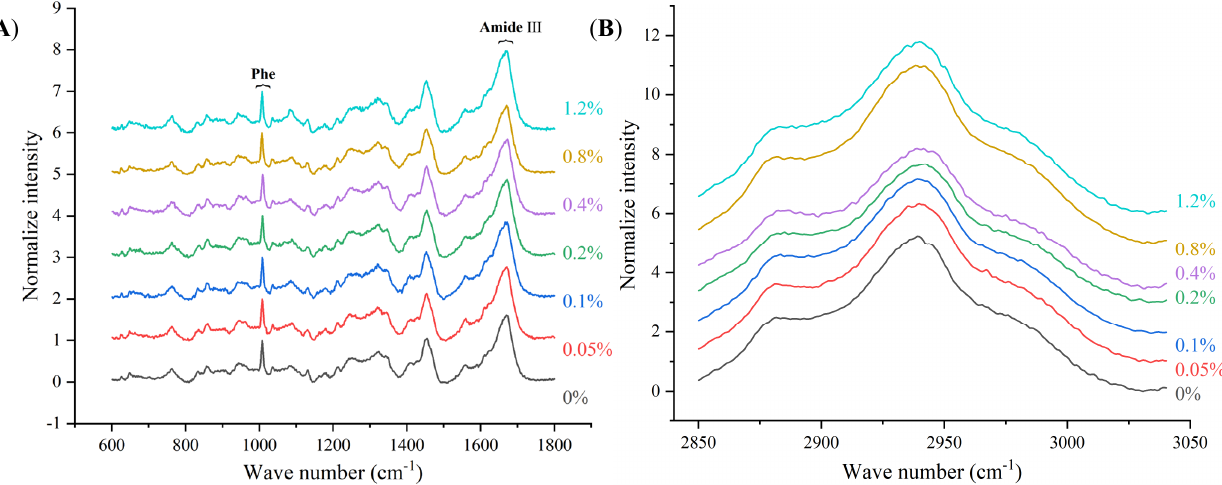
Figure 3. Raman spectrum between 600 and 1800 cm − 1 of composite MP gels concentrations of CG ( A ); Raman spectrum between 2850 and 3050 cm − 1 of composite MP gels concentrations of CG ( B ). 0%: the control; 0.05%: MP with 0.05%CG; 0.10%: MP with 0.1% CG; 0.20%: MP with 0.2% CG; 0.40%: MP with 0.4%CG; 0.80%: MP with 0.8% CG; 1.20%: MP with 1.2% CG.